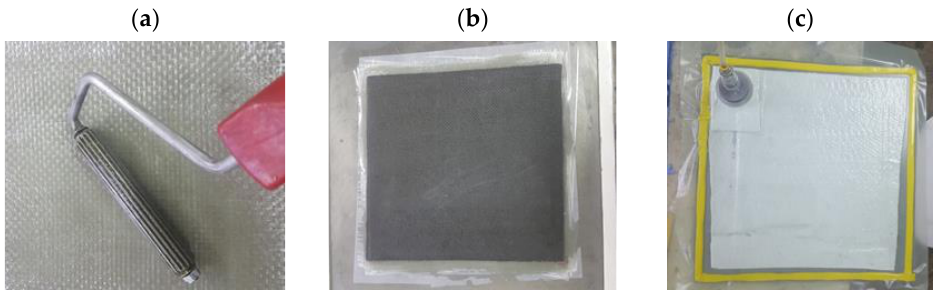
Figure 2. The scheme of GFRP pressing device: 1 — worktable, 2 — mold, 3 — composite layers, 4 — foil, 5 — pressing cylinder device, 6 — resin excess.